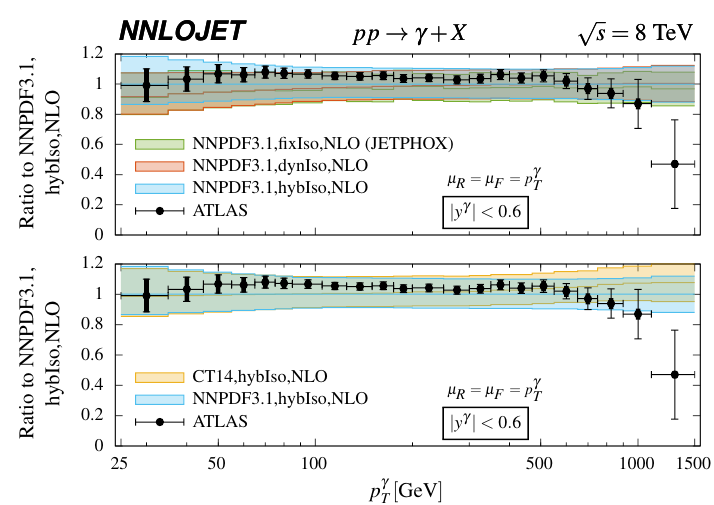
Figure 3 . Impact of the choice of the photon isolation criterion (dynamical isolation [30] and (cid:12)xed-cone isolation (produced with JETPHOX [36]) versus hybrid isolation, top frame) and PDF set (CT14 [78] versus NNPDF3.1 [60], bottom frame) at NLO, shown as ratio to our default choice of NNPDF3.1 with hybrid